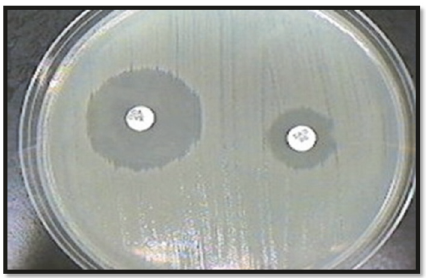
Figure 1: Disc potentiation test for detection of ESBL using ceftazidime (Right) and ceftazidime-clavulanic acid disc (left).